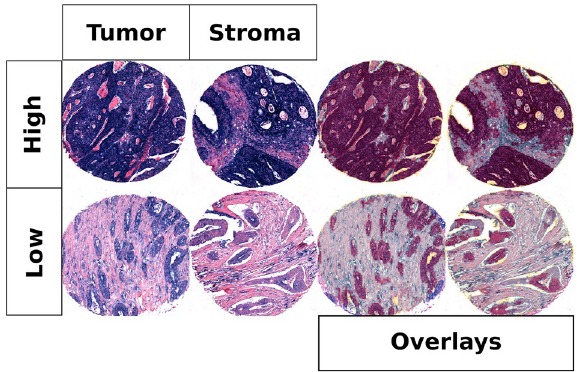
Figure 1. High and low scores for miR-126 in tumor and stroma with and without